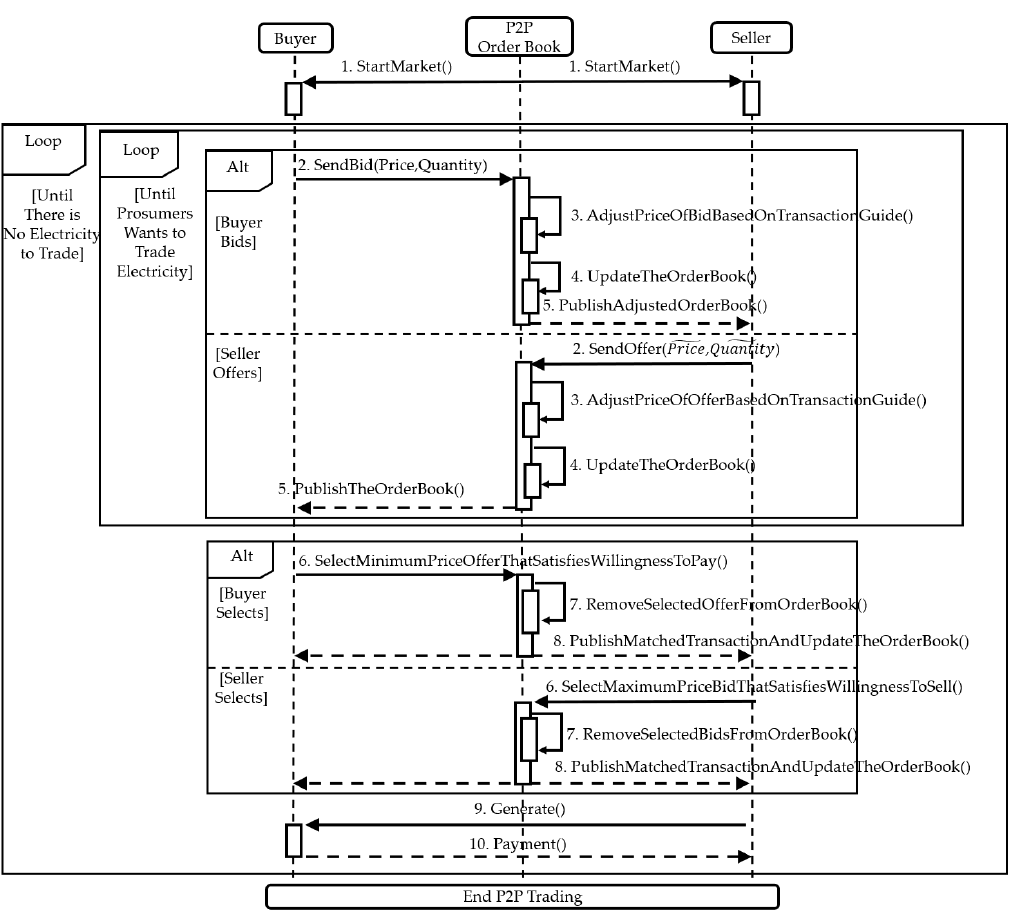
Figure 4. The sequence diagram of the new loss management framework.